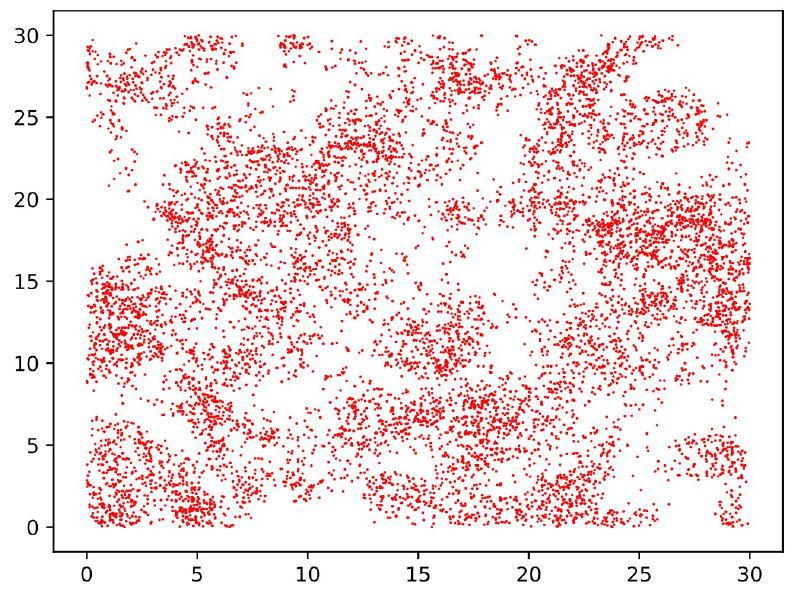
Figure 3. Aggregation of vehicles’ location at different time